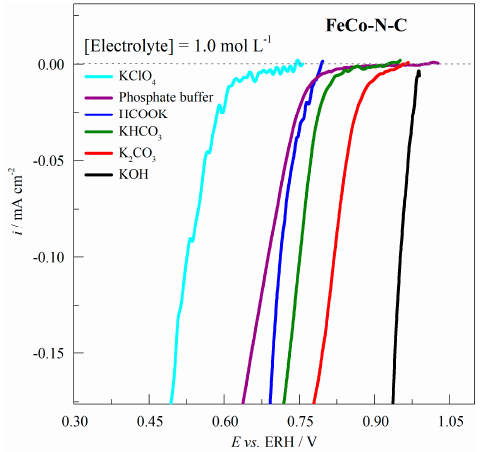
Figure 6. Steady ‐ state polarization curves for the ORR on FeCo ‐ N ‐ C, showing the high potential domain, obtained in the different O 2 ‐ saturated electrolytes, as indicated in the figure inset. Scan rate: 5.0 mV s − 1 . Rotation rate: 1600 rpm.